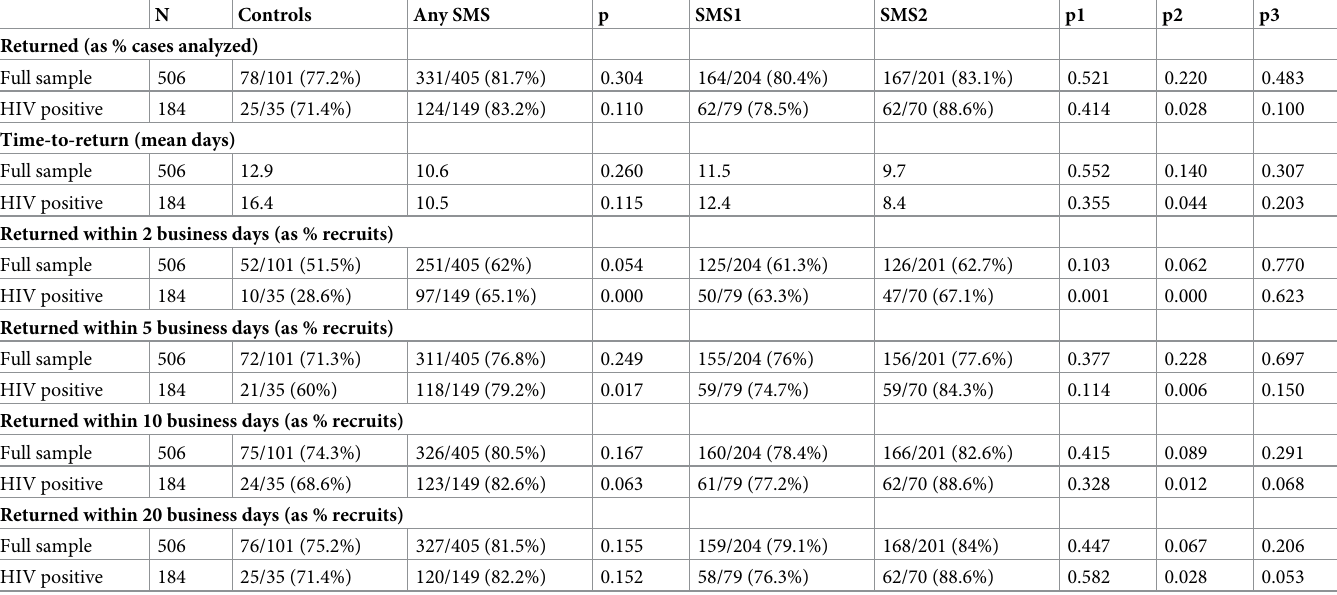
Table 2. Intent-to-treat